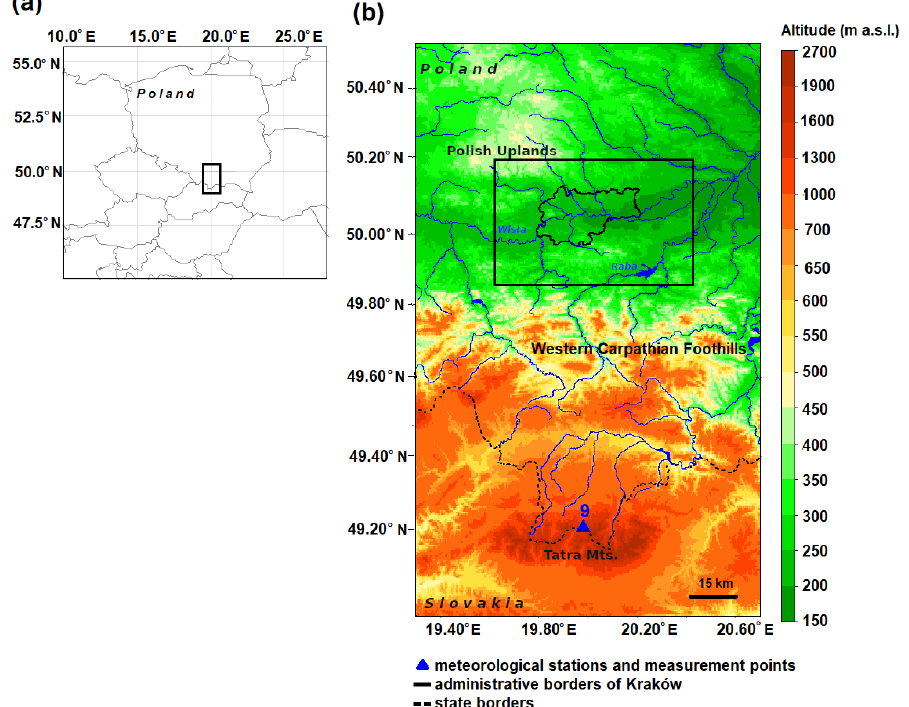
Figure 1. Location of the region studied: (a) in central Europe; (b) in southern Poland. Explanations: station no. 9 as in Table 2. The black frame in (b) represents the analysed area shown in Fig. 2.